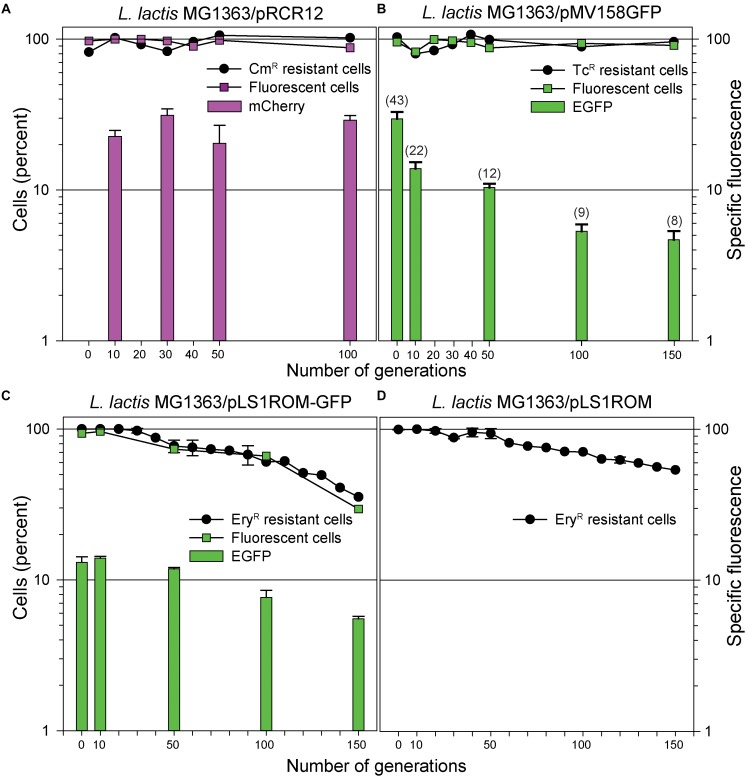
Analysis of the segregational stability of various plasmid constructs in L. lactis MG1363. The stability of inheritance of pRCR12 (A), pMV158GFP (B), pLS1ROM-GFP (C), and pLS1ROM (D) was analyzed after growing lactoccocal cells for at least 100 generations in the absence of selective pressure. An estimation of the percentage of antibiotic resistant cells at the indicated number of generations is given in the four panels. The percentage of fluorescent cells directly quantified by fluorescence microscopy is depicted at the indicated number of generations for those strains producing mCherry (A) or EGFP (B,C). The vertical bar graph in (A–C) represents the specific fluorescence emitted by the total cell population at the indicated number of generations. In (B), the qPCR-determined PCN of pMV158GFP at the indicated number of generations is depicted in brackets on the top of the vertical bars representing the specific fluorescence.